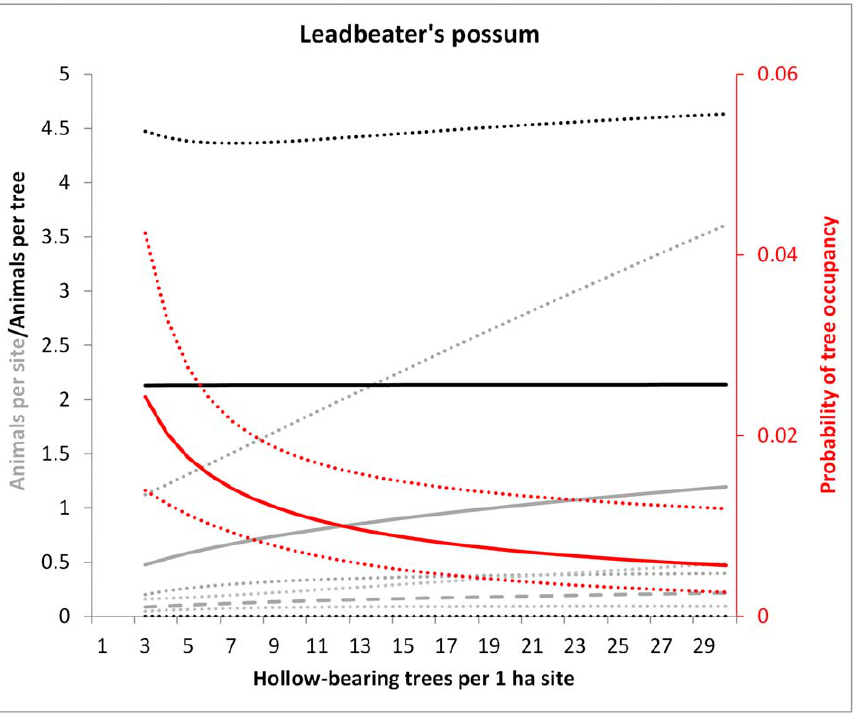
Figure 6. Model predictions for the Leadbeater’s possum of the number of animals per site in 1983 regrowth forest (solid grey line) and older forest (dashed grey line), the probability of occupancy per tree (red) and the number of animals per occupied tree (black) in relation to the number of hollow trees per 1 ha site. Dotted lines show 95% confidence intervals. Predictions were averaged over the non- represented variables (e.g. tree form). All relationships were non-significant except for the occupancy rate (red).